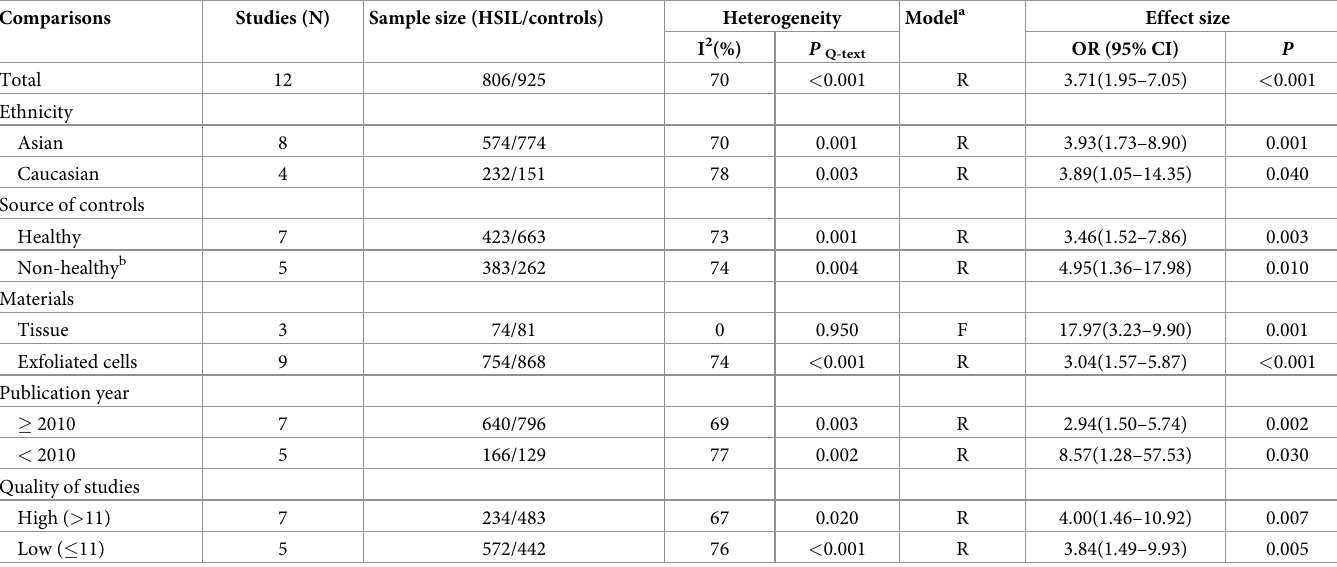
Table 4. Pooled results for the association of MGMT promoter hypermethylation with HSIL